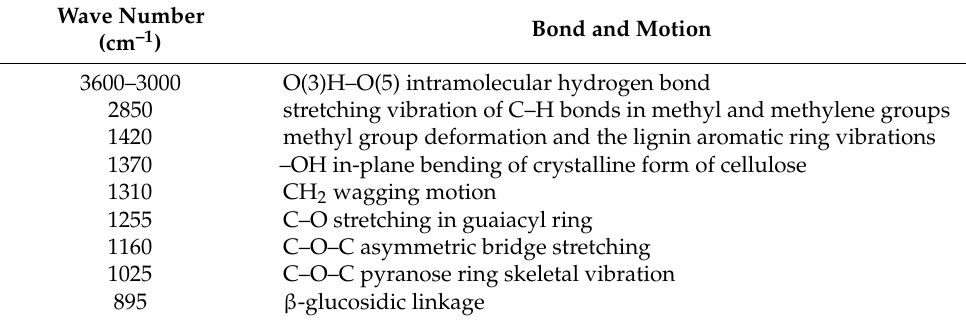
Table 3. Characteristic FTIR peaks and corresponding motions of organic bonds.